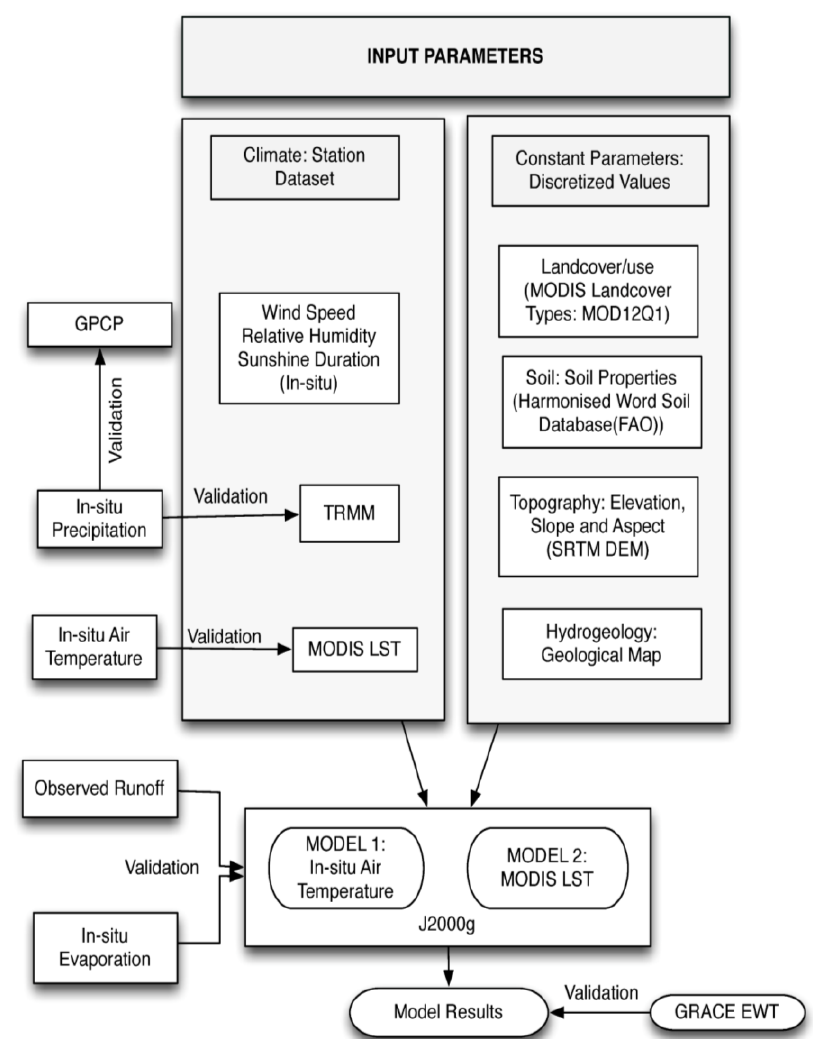
Figure 6. J2000g model input parameters for both simulation and